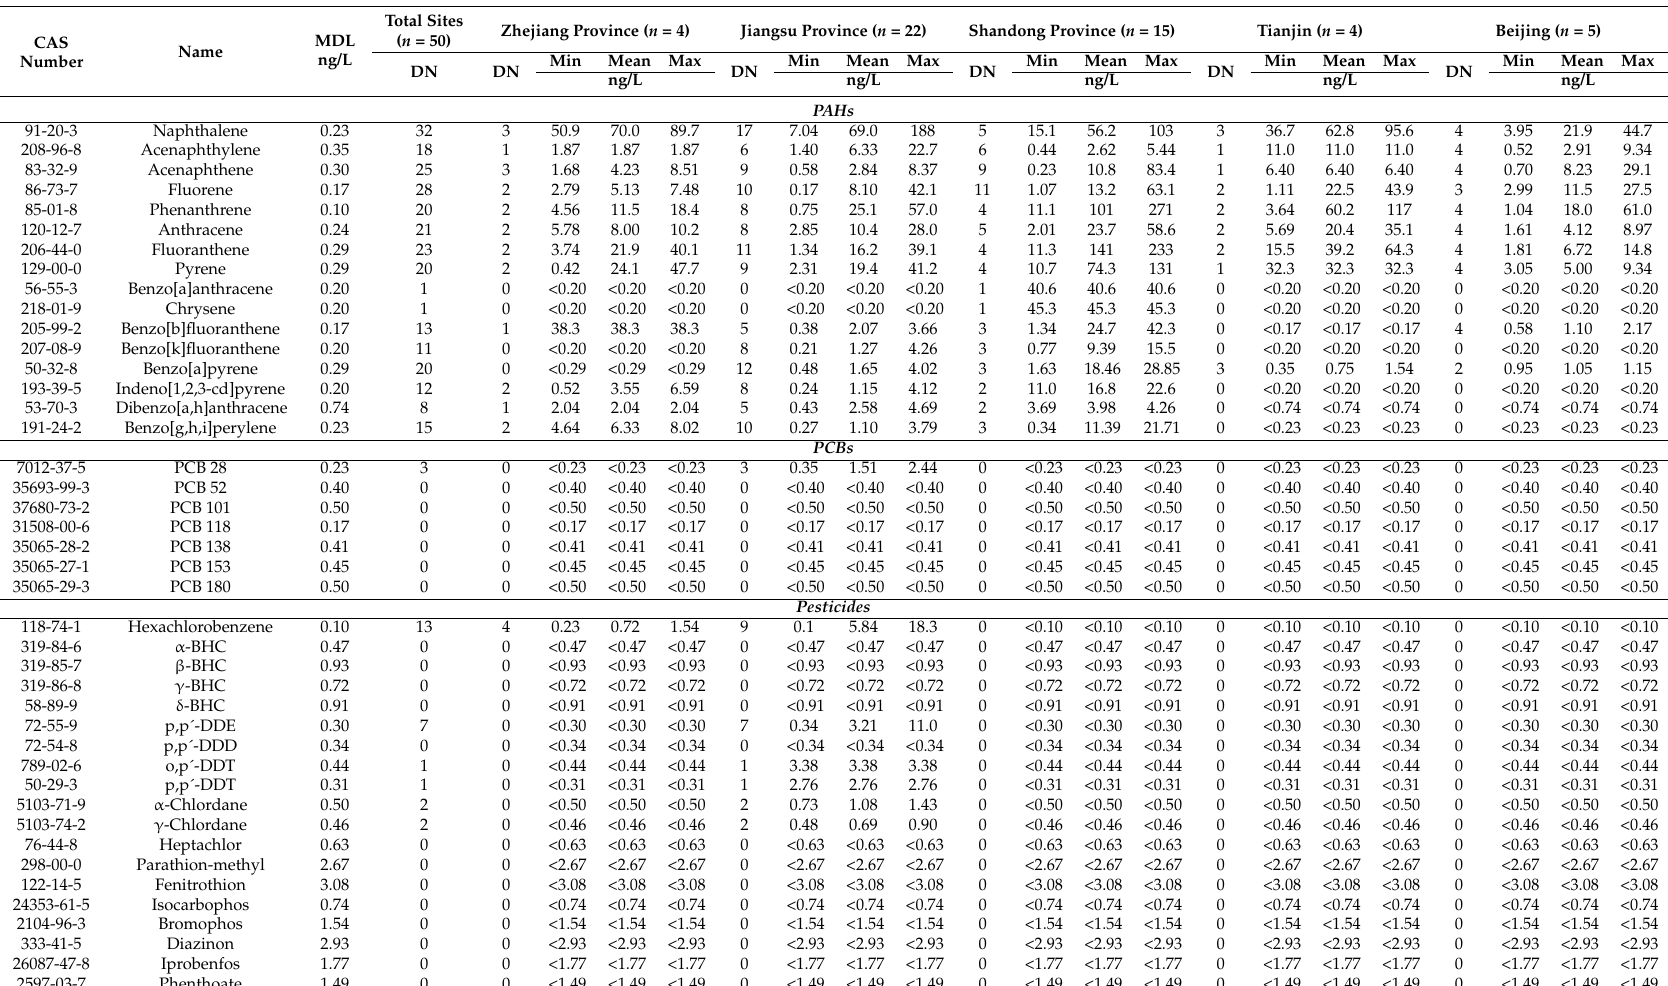
Table 2. Method detection limits (MDL), detection number (DN) and concentrations of